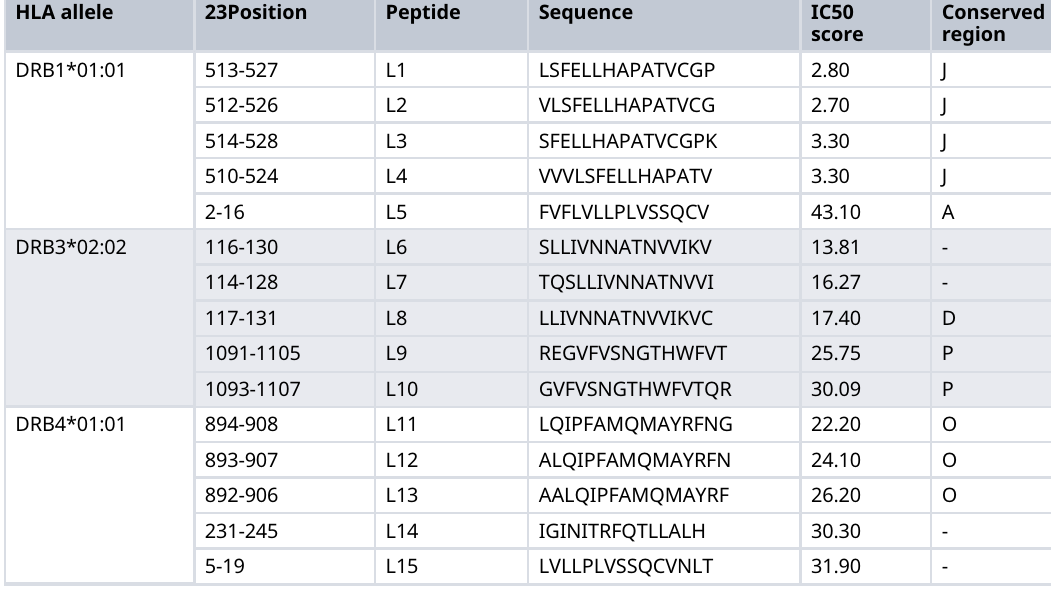
Table 2. Prediction results of CD4+ T cell epitopes of SARS-CoV-2 spike glycoprotein. HLA allele